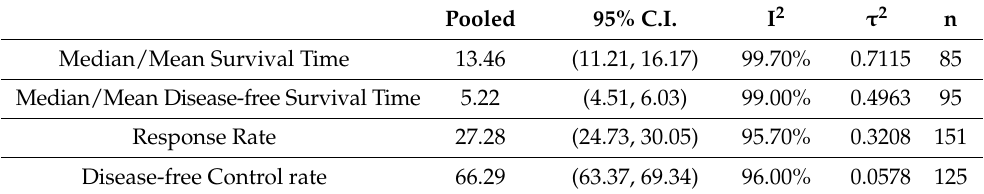
Table 1. Results of random effects meta-analyses for median/mean survival time (in months), median/mean disease-free survival time, response rate, and disease-free control rate. Pooled 95% C.I. I 2 τ 2 n Median/Mean Survival Time 13.46 (11.21, 16.17) 99.70% 0.7115 85 Median/Mean Disease-free Survival Time 5.22 (4.51, 6.03) 99.00% 0.4963 95 Response Rate 27.28 (24.73, 30.05) 95.70% 0.3208 151 Disease-free Control rate 66.29 (63.37, 69.34) 96.00% 0.0578